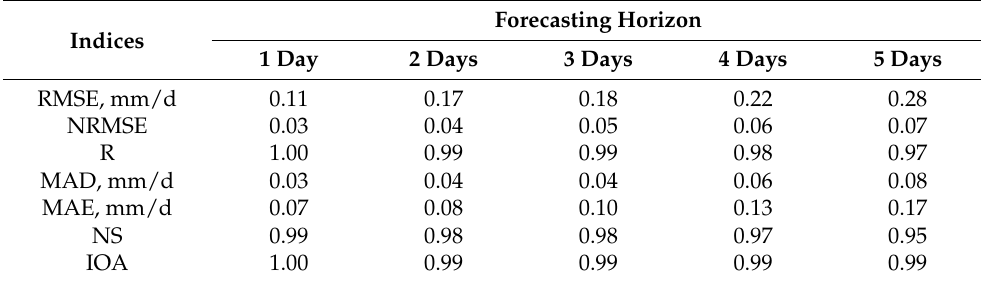
Table 12. Multi-day-ahead forecasting performance of the Bi-LSTM model on the test dataset at Gazipur